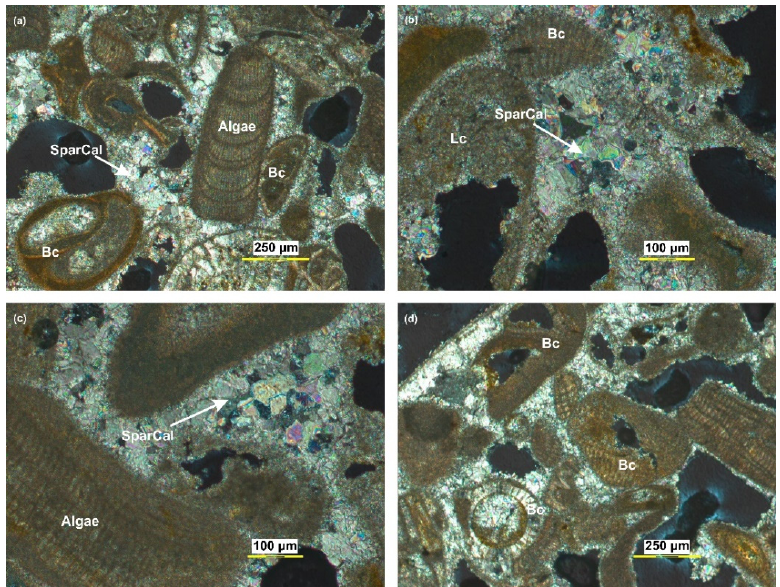
Figure 9. Representative photomicrographs under crossed polars illustrating caprock composition of marine terrace VI. The photomicrographs are taken from polished thin sections of caprock sample KEAM SparCal: Sparitic Calcite cement, Lc: lithoclast, Bc: bioclast. Well-developed calcite crystals with light brown color are indicative of cement. ( a , b ) Thick cement consolidates bioclasts, lithoclasts and minerals, ( c ), Close look of the bonding between bioclasts and algae by spartic calcite, ( d ) high contribution of bioclast.